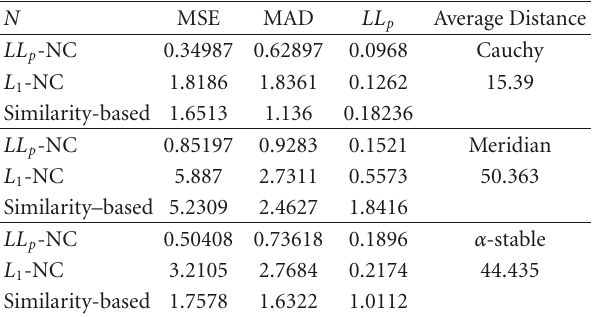
Table 2: Clustering results for GCD processes and α -stable